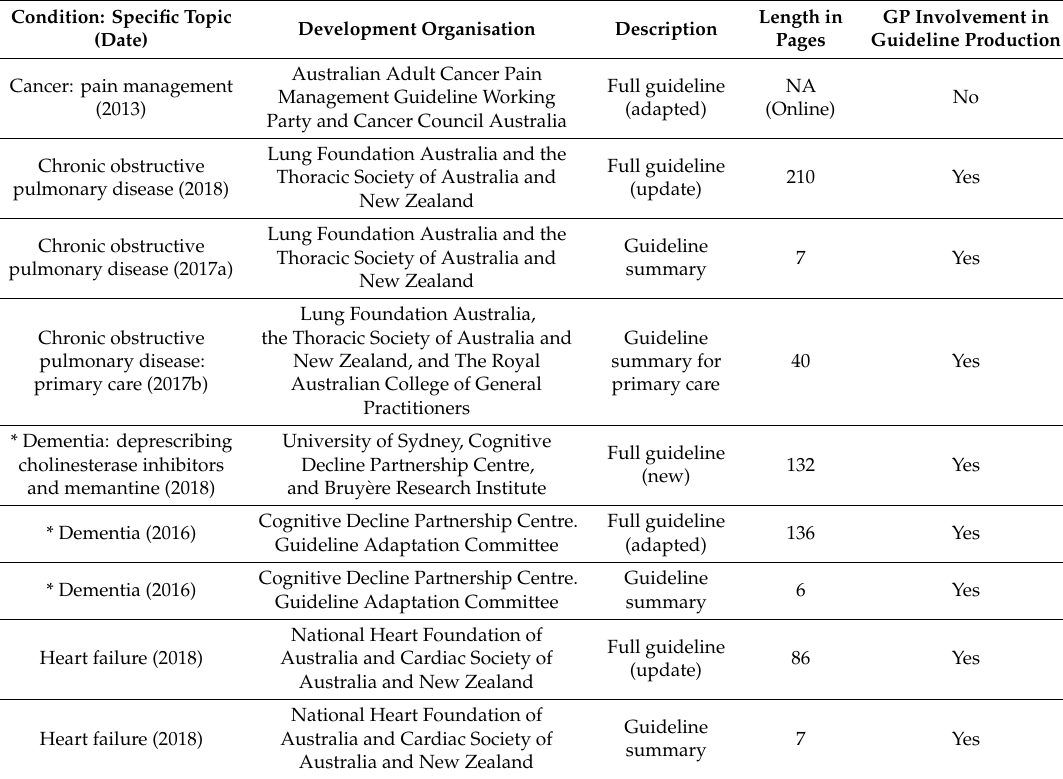
Table 2. Characteristics of included guidelines.